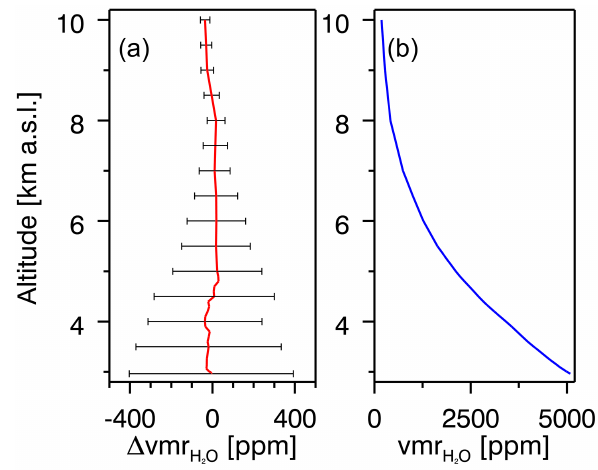
Figure 4. (a) Uncertainty analysis of NCEP water vapor profile shape. Red is the mean difference between NCEP profiles normal- ized with respect to IWV and an ensemble of best-estimate profiles derived from pairs of radiosondes launched with a 1h separation (also normalized for IWV). Black error bars indicate 2 σ differences. (b) Mean water vapor profile used in the uncertainty